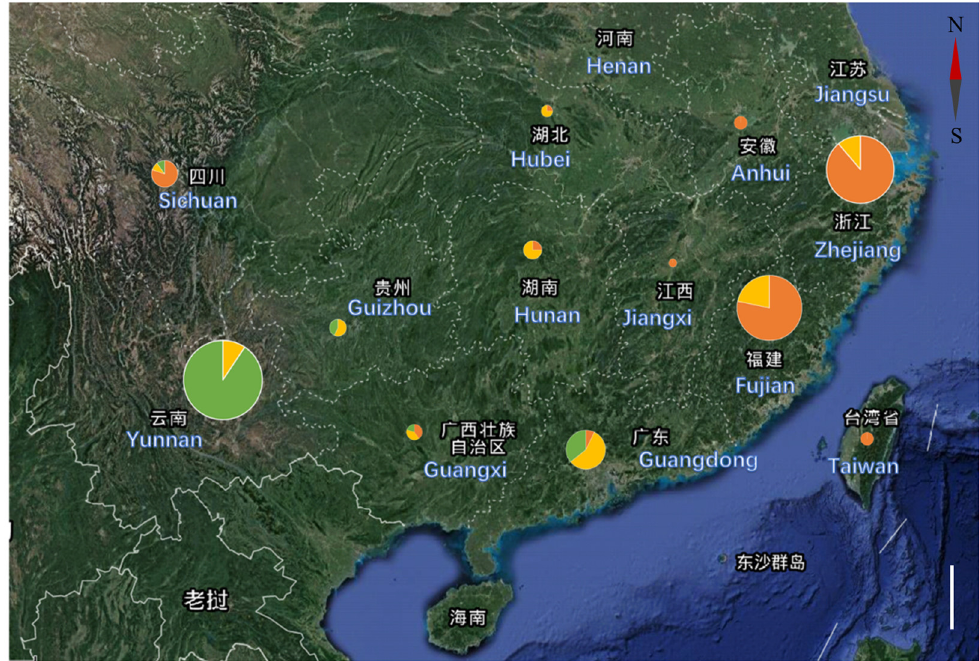
Figure 1. Geographical origins of tea cultivars from different provinces in China; green, Assam type (CSA); orange, Chinese type (CSS); and yellow, transitional type. The different colored areas in the pie chart represent the proportion relative to the total number of tea cultivars. Scale bar: 200 Km.